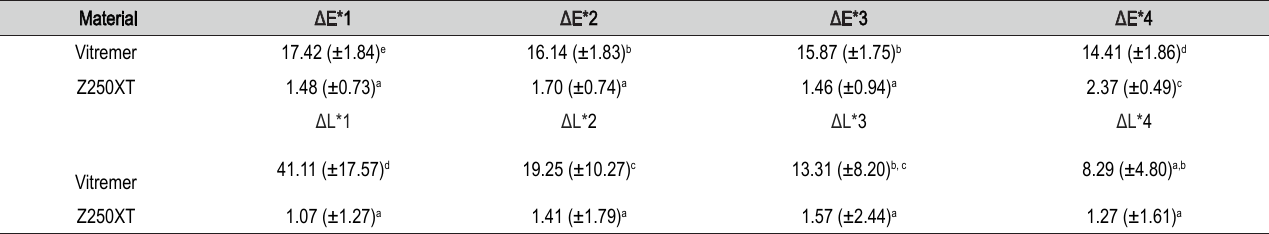
Table 2 - Mean values (Standard deviation) of Color variation ΔE* and Lightness variation ΔL* of Vitremer and Z250 XT , between each time period and baseline.